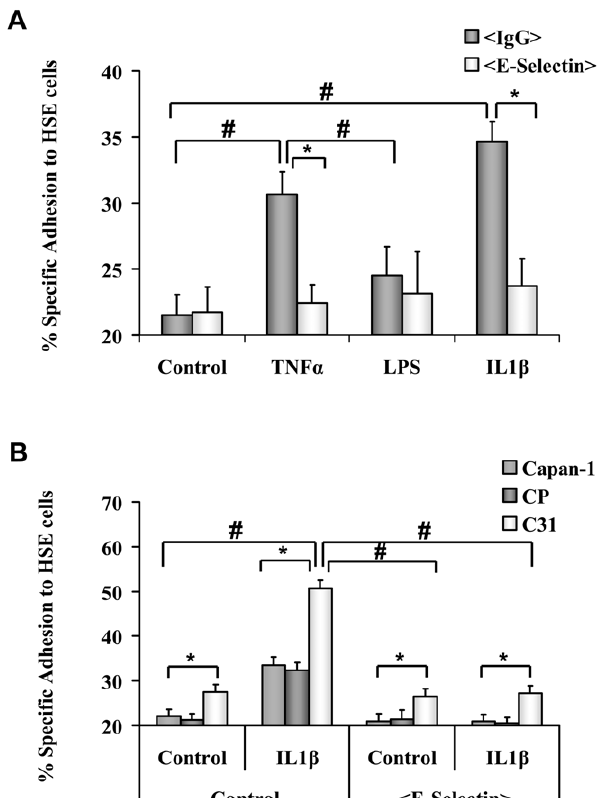
Figure 4. E-selectin induction on Primary Cultured Hepatic Sinusoidal endothelium (HSE) cells (Figure 4A). HSE cells were incubated with , Sel . = anti-murine CD62 E (E-selectin) MAb or , IgG . = isotype-matched control antibody. Parental Capan-1 cells were labelled with calcein and added to HSE control cells, TNF- a stimulated HSE cells, LPS stimulated HSE cells or IL-1 b stimulated HSE cells. Results are expressed as the % Specific adhesion to HSE cells [78]. Data represents the mean 6 SD of 3 separate experiments, each in three replicates (n=9). * Significantly different ( P , 0.001 ) when comparing anti-E-selectin incubated HSEC to control cells. # Signifi- cantly different ( P , 0.001 ) when comparing treatments. Tumour cell adhesion assay to Primary Cultured HSE cells (Figure 4B). Capan-1 variant cells were labelled with Calcein and added to IL-1 b stimulated HSE cells or ( 2 ) not stimulated HSE control cells. , Sel . = anti-murine CD62 E (E-selectin) MAb was added to IL-1 b HSE cells or - HSE cells before tumour cell addition. * Significantly different ( P , 0.001 ) when comparing Capan-1, CP, and C31 cells. # Significantly different ( P , 0.001 ) when comparing each clone (Capan-1, CP and C31) adhesion for the different HSE cell treatments.